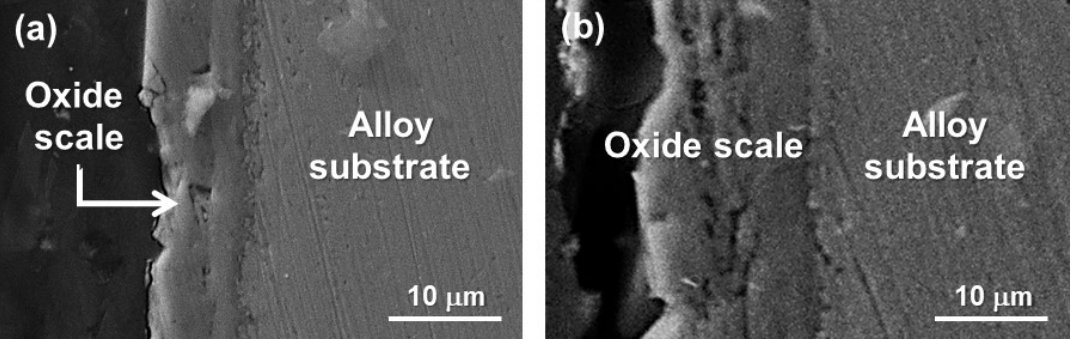
Figure 4. Cross-sectional SEM images of DS2205 samples exposed to molten salts for: ( a ) 300 h, and ( b ) 1600 h.